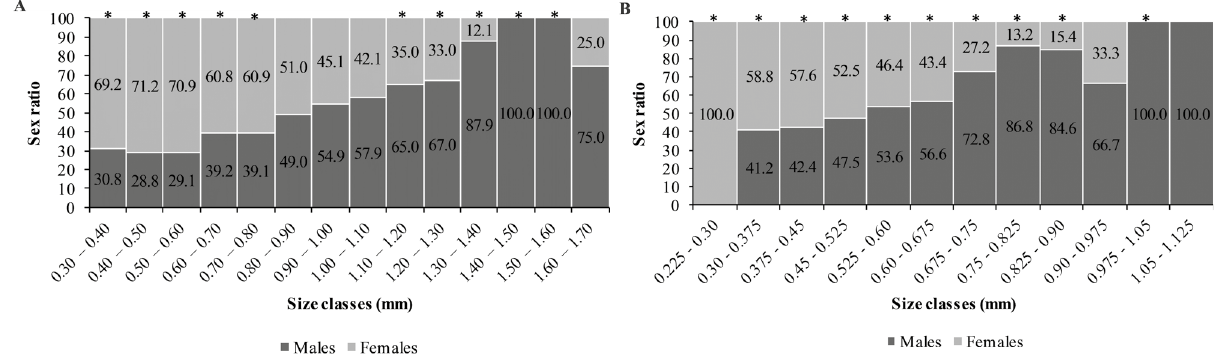
Figure 5. Sex-ratio by size classes in Hyalella georginae (A) and Hyalella gauchensis (B), Palmeira das Missões, state of Rio Grande do Sul. Brazil. Asterisks above the columns indicate significant diferences between the proportions of males and females (p < 0.05). All sizes shown in the graph have at least one measured